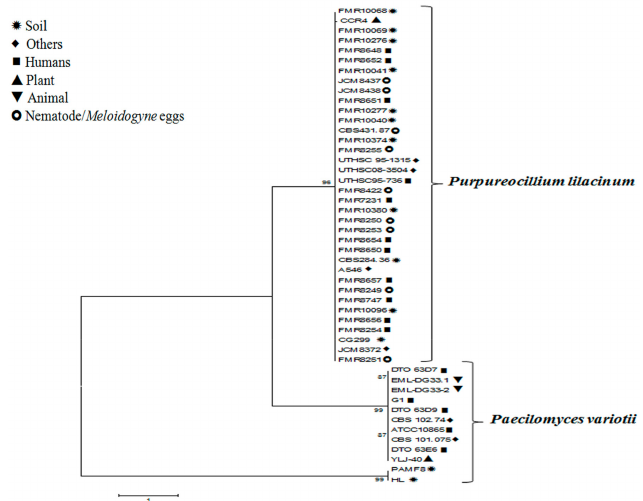
Figure 1. Phylogenetic tree of Purpureocillium lilacinum and Paecilomyces variotii isolates. Similarity between clinical and environmental Purp. lilacinum isolates is shown. P. variotii isolates show one possible differentiation between human and animal (clinical) isolates from soil isolates